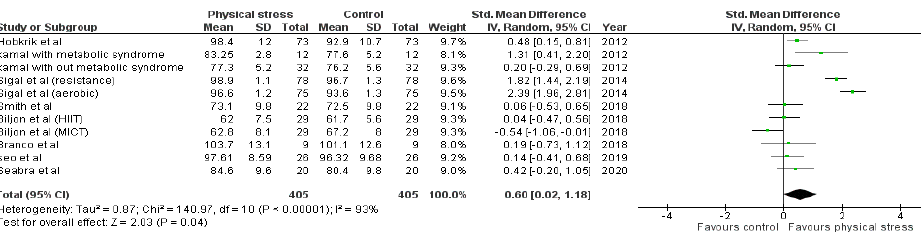
Figure 9. Forest plot showing the results for waist circumference.